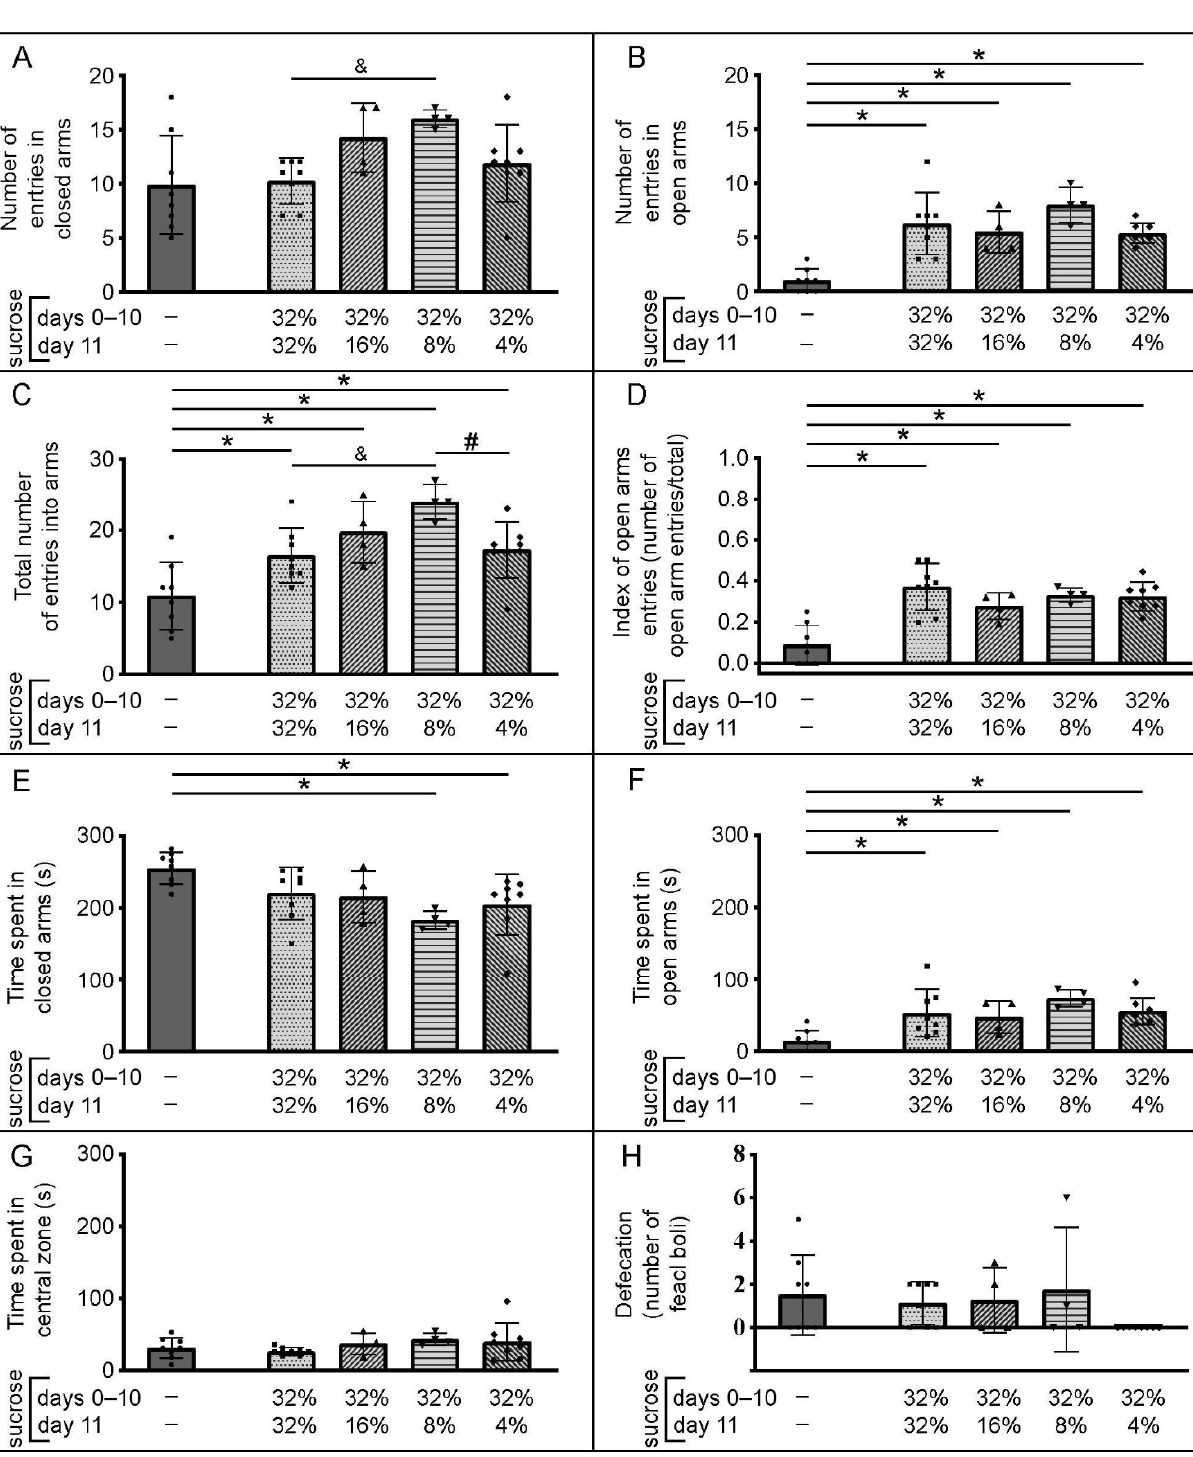
Figure 5. Changes in behavior of adult male C57BL/6J mice in the elevated plus maze associated with ad libitum access to sucrose solution(s). Panels A–H represent different parameters scored in the elevated plus maze test or calculated using scored ones (( A ) Number of entries in closed arms; ( B ) Number of entries in open arms; ( C ) Total number of entries into arms; ( D ) Index of open arms entries; ( E ) Time spent in closed arms; ( F ) Time spent in open arms; ( G ) Time spent in central zone; ( H ) Defecation). The data are represented as mean ± SD, with individual data plots along column bars (8 animals per group in all except in 32% → 16% and 32% → 8% downshifted groups, which have 4 animals per group). The behavior of the animals was monitored/recorded during the first 5 min after the placement in the center of the maze and the results were obtained by subsequent analysis of the recorded material. * p ≤ 0.05 vs. the control group, which had no experience with